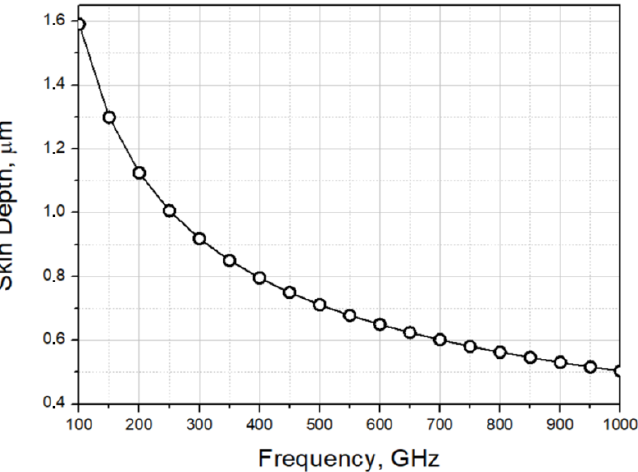
Figure 4. Dependence of skin depth on frequency for film with resistance of 180 Ω / □ .